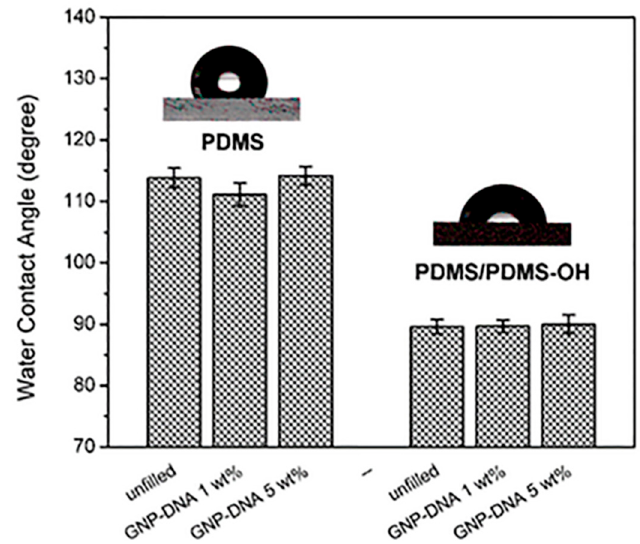
Figure 11. Comparison of the surface hydrophobicity of the standard PDMS (Sylgard 184) and the PDMS / PDMS–OH blend (75:25 w / w), unfilled and after the addition of 1 wt% and 5 wt% of GNP–DNA, as determined by the sessile drop method.